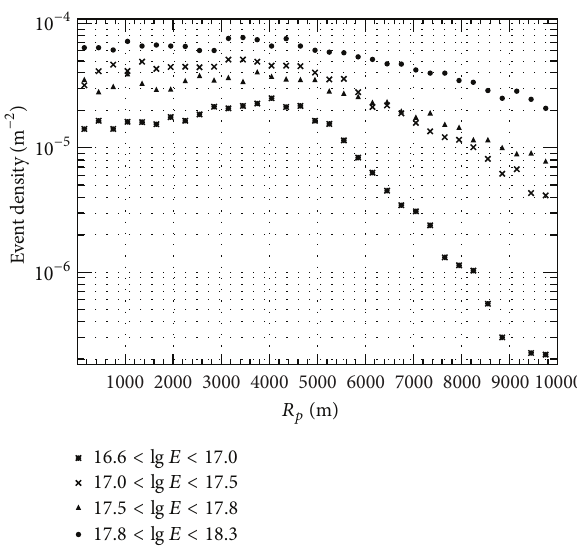
Figure 7: Event density distribution as a function of 𝑅 𝑝 . Different points represent different energies.